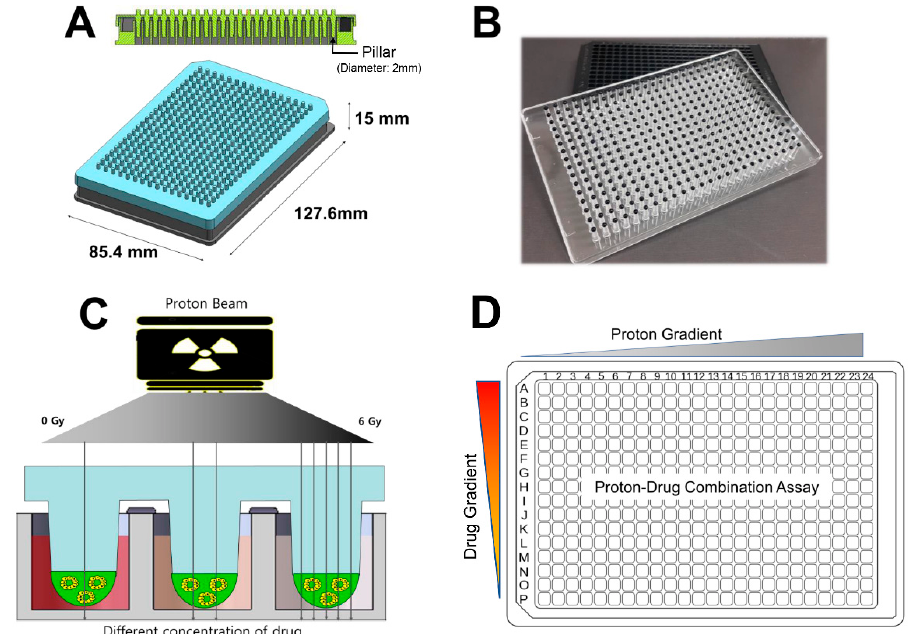
Figure 1. The 3D spheroid-based 384-pillar/well platform used for this study: ( A ) schematic view of the 384-pillar/well platform; ( B ) fabricated platform; ( C ) schematic view of proton–drug combination screening; ( D ) layout of the proton–drug combination.